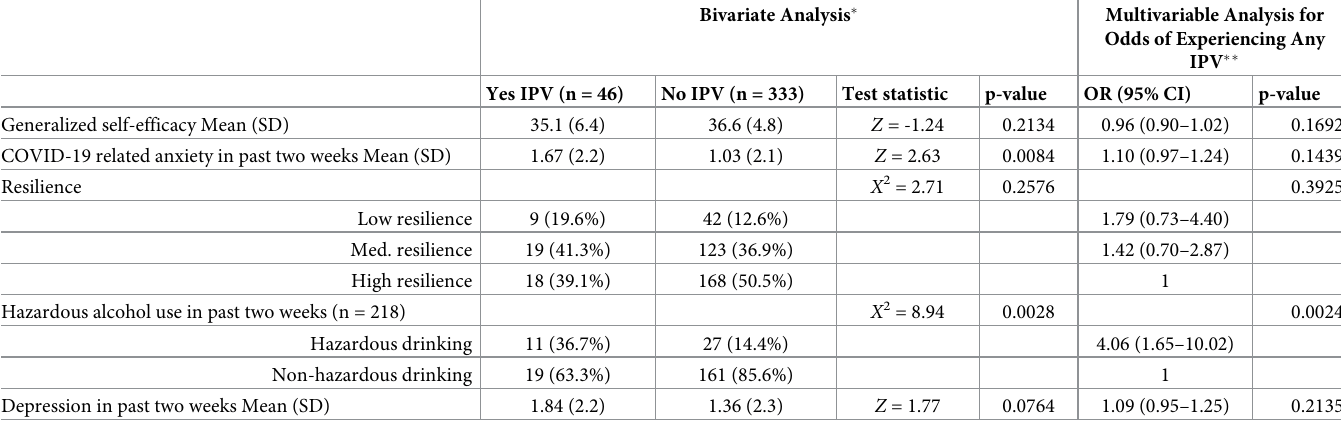
Table 5. Mental health, resilient coping, general self-efficacy, and hazardous alcohol use by experience of physical IPV victimization in past 6 months (n =